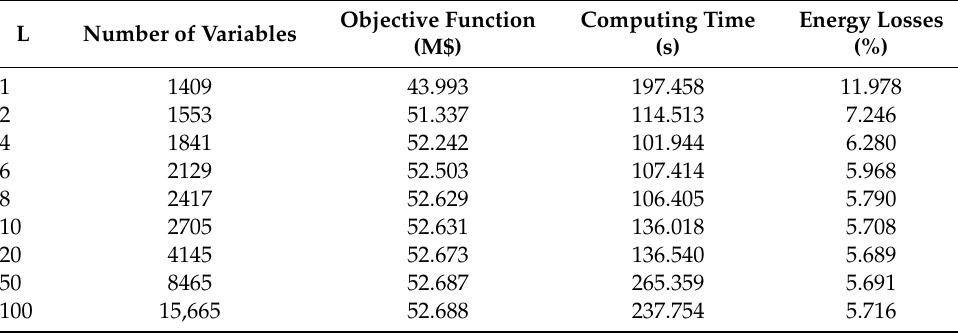
Table 4. E ff ect of linearization